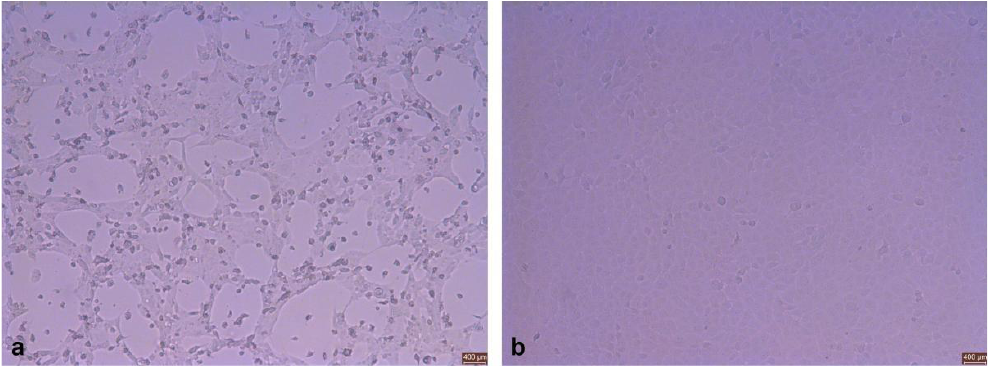
Figure 1. Observed cells after inoculation (×100). ( a ) Cytopathic effects. ( b ) Normal cells. M gene fragments of BPIV3 were detected from nine samples that produced cyto- pathic lesions, fragments that were consistent with the expected size of 686 bp band and matched the size of the target fragment. The polymerase chain reaction products were identified as BPIV3 by a sequencing comparison and named XJ21032-1, XJ21032-18,